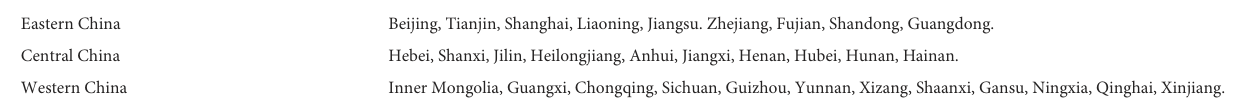
TABLE 2 Regional division of China.